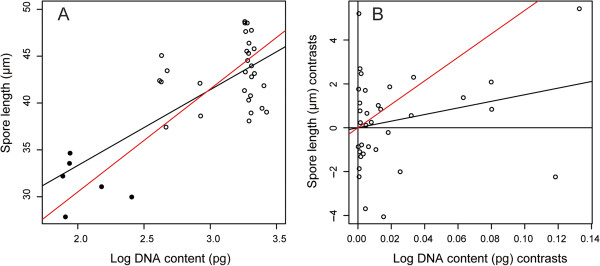
Regression analyses of 38 specimens showing the positive relationship between DNA amount and spore length for both (A) the raw data (p = 4.57x10-6, r2 = 0.542, slope = 10.986, 95% CI’s = 8.665-13.929), and (B) data from the phylogenetically independent contrasts analysis (Branch transformation of Grafen; SMA, p = 0.101) (see Table 3). DNA amount values were logged prior to analysis, and the values used for DNA amount were based on reproductive mode: i.e. 2C-values were used for apomictic taxa, and 1C-values were used for sexually reproducing taxa. Lines of best fit are indicated using LM (black line) and SMA (red line) models, and in B only, the SMA is forced through the origin. In plot A, open circles represent apomictic taxa, and filled black circles represent sexually reproducing taxa.